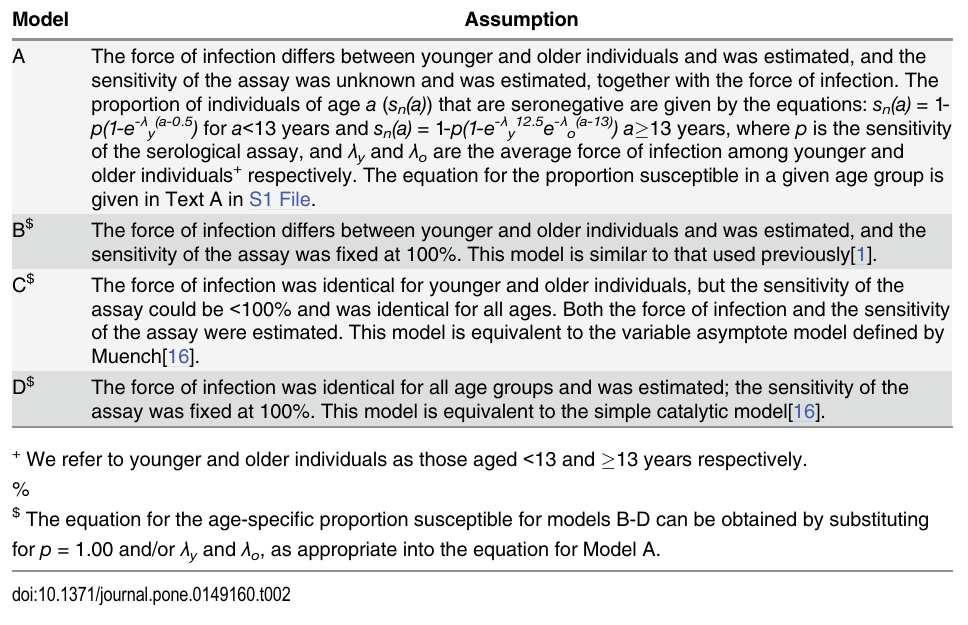
Table 2. Summary of the catalytic models used in the analyses of serological data. Note that the lower case letter “ a ” in the equations below refers to the single year band, whereas “ A ” (see Eq 1 in the main text) refers to those in the age group of interest, A